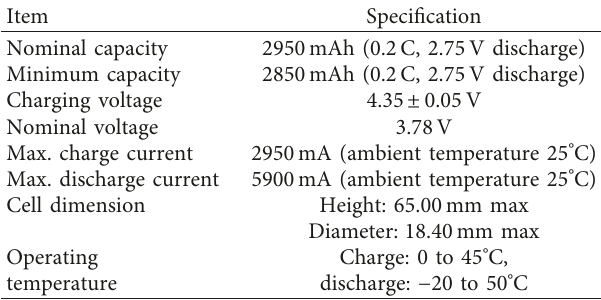
Table 1: Cell specifications of the